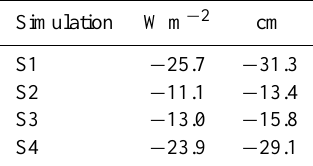
Table 1. Simulated 2010–2012 annual mean latent heat and water equivalent exchange at the surface in 4 Crocus snow-pack model runs using different input atmospheric surface boundary conditions: S1: Purely ECMWF data S2: Observed data of temperature, relative humidity and wind, oth- erwise ECMWF data S3: Observed data for temperature and relative humidity, otherwise ECMWF data, including wind speed S4: Observed data for wind, otherwise ECMWF data, including temperature and moisture.